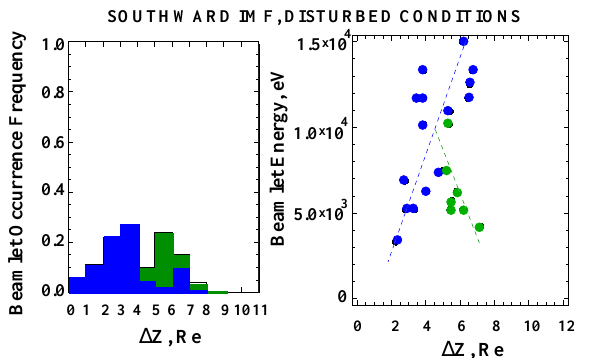
Fig. 8. The same as Fig. 6 obtained during quiet northward IMF time